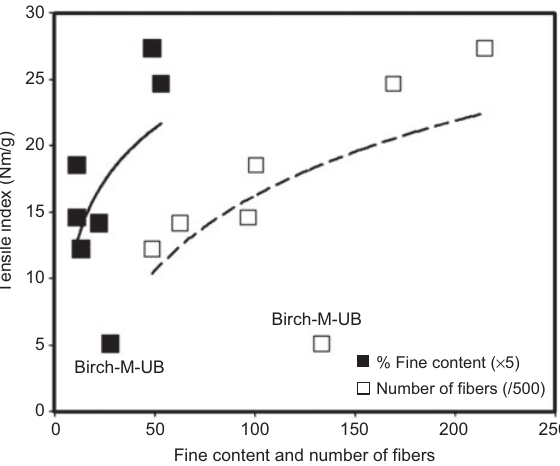
Figure 6 Increasing fine content and number of fibers in a given amount of pulp reduced zero-span tensile index of final sheets.